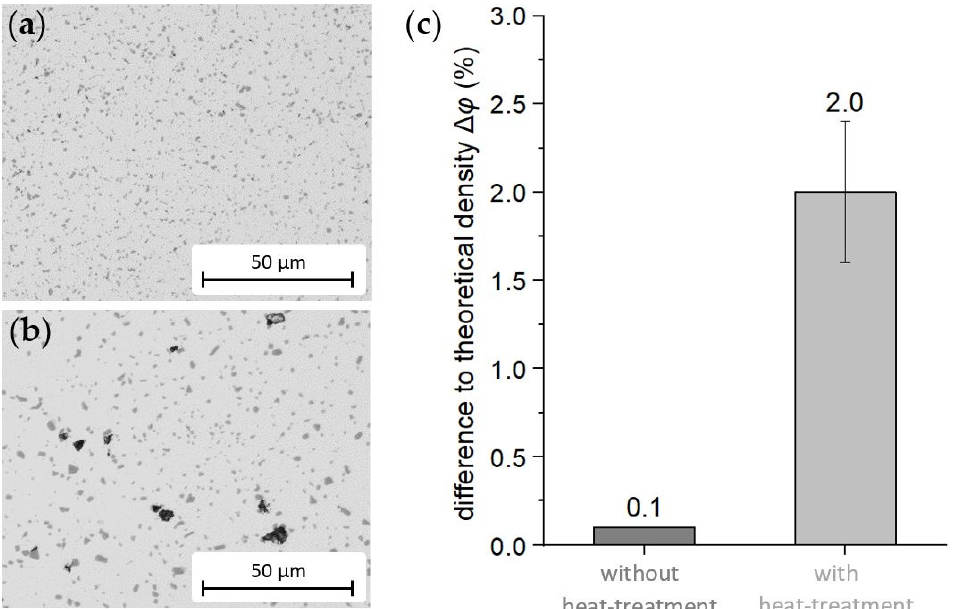
Figure 7. Comparison of the microstructures between ( a ) as-sintered and ( b ) heat-treated condition. ( c ) Results of density determination. The porosity was significantly higher for the heat-treated samples compared to the as-sintered material.